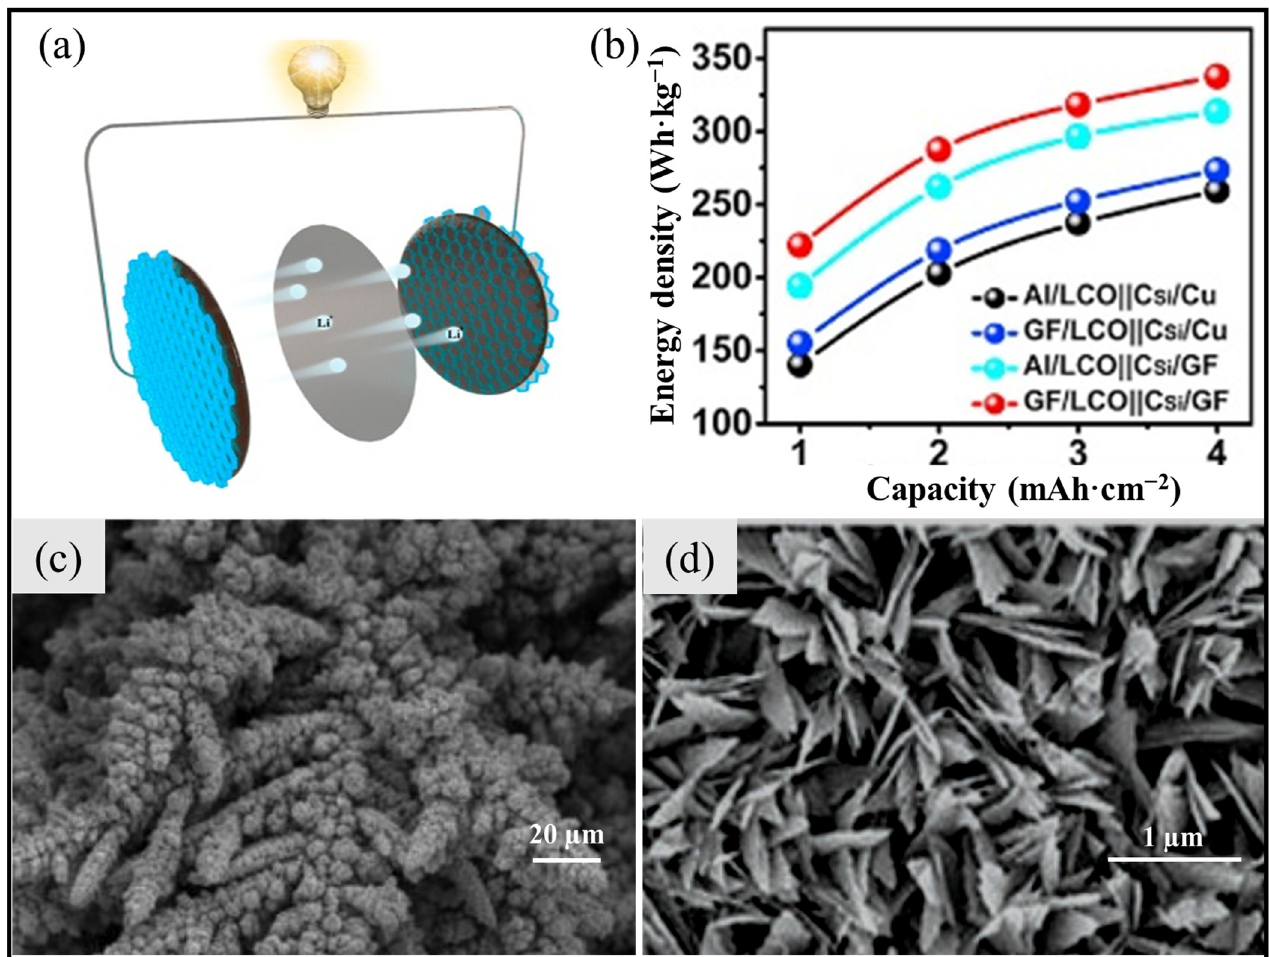
Figure 3. ( a ) Schematic diagram of graphite film||Li cells; ( b ) Electrode energy density change with increasing area capacity of LiCoO 2 ||Csi full-cells with different current collectors [83] ( c ) Scanning electron microscopy images of a dendritic copper current collector [84]. ( d ) Top and side views of VA-CuO-Cu current collectors [77].